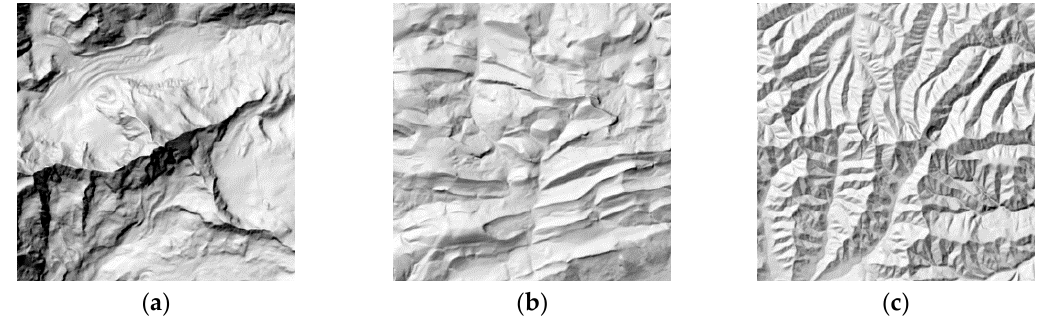
Figure 2. Standard hillshading with north-west (NW) illumination of sample areas with: ( a ) block mountains; ( b ) folded mountains; ( c ) mountains formed by erosion processes.